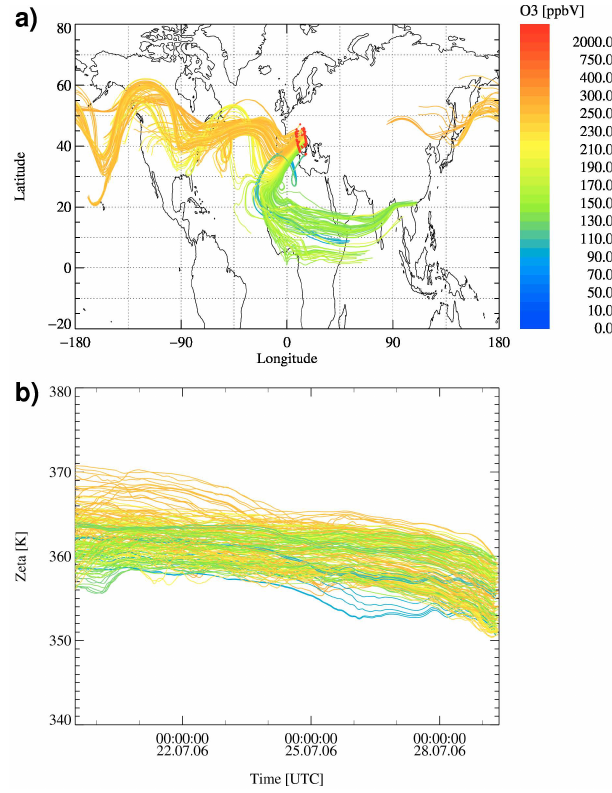
Fig. 6. Panel (a) : Map with 10 day backward trajectories from CLaMS starting at the CRISTA-NF grid positions between 350 and 360K ζ . Color coding shows the CLaMS O 3 on the CRISTA-NF grid (without filtering) during the flight on 29 July 2006. The mea- surement positions are marked with red diamonds.The vertical po- sition of the 350K ζ level is marked in Fig. 8b. Panel (b) : Vertical position of the backward trajectories on ζ